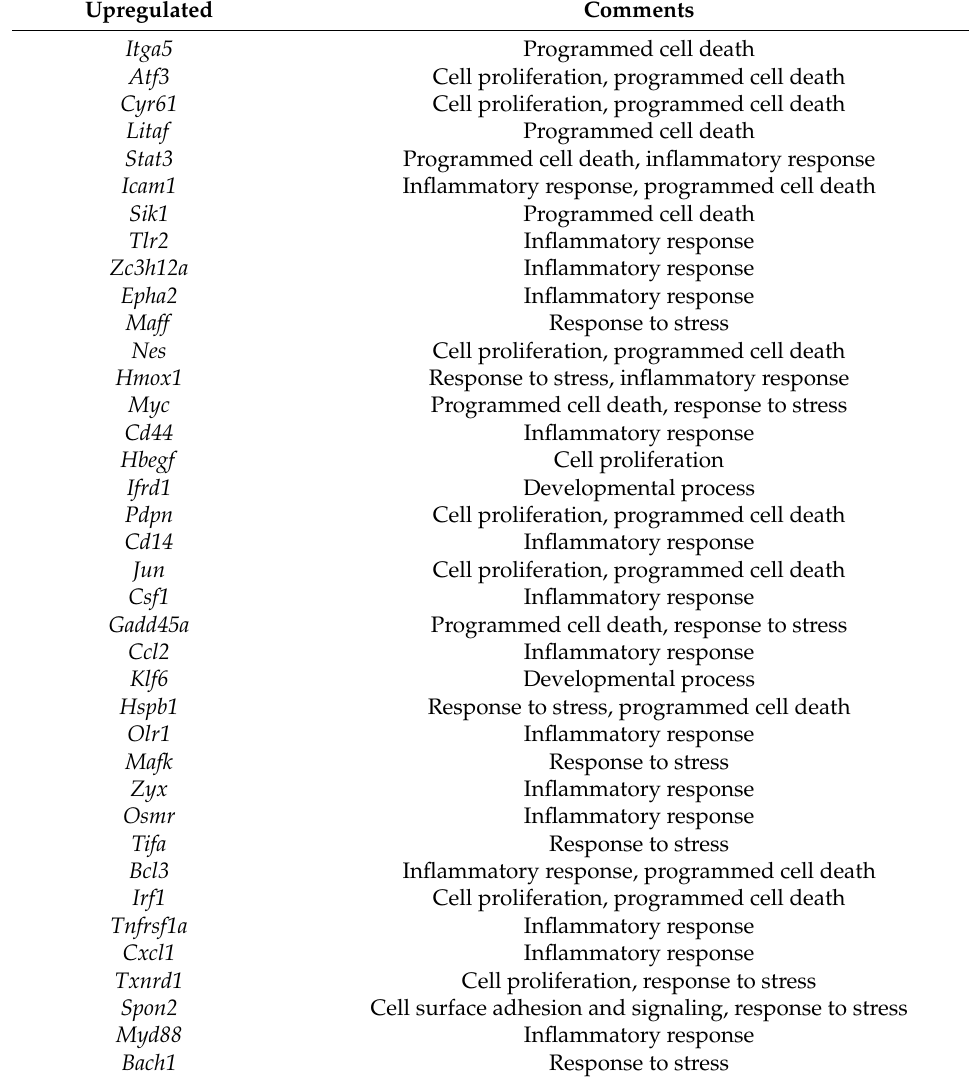
Table 2. Highly repeated up-regulated genes in IRI.